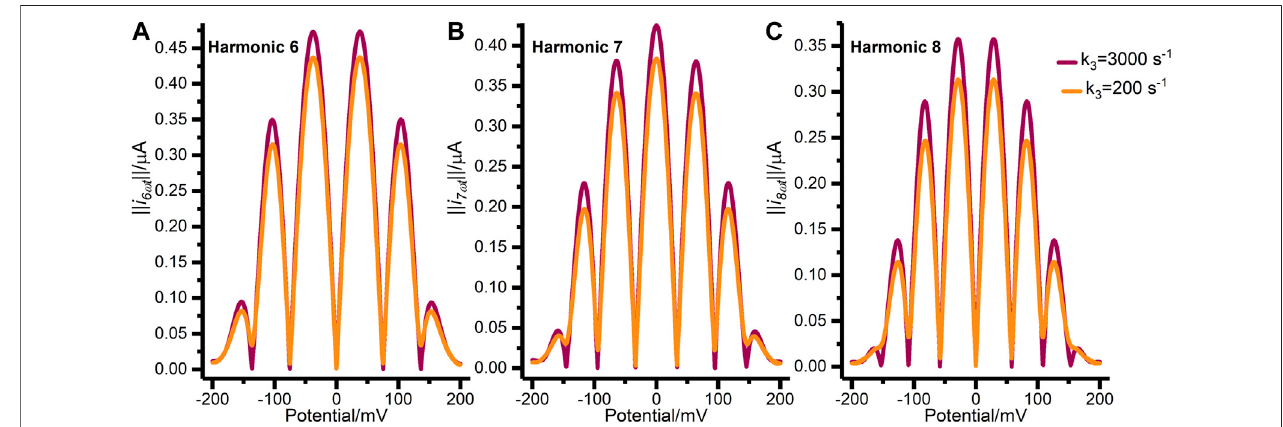
FIGURE 4 | Synthetic FTACV data showing (A) harmonic 6, (B) harmonic 7, and (C) harmonic 8 generated by the concerted two-electron transfer model with k 3 (cid:2) 3 , 000 s − 1 (purple) and k 3 (cid:2) 200 s − 1 (orange). The other parameters used to generate these harmonics were: E start (cid:2) 200 mV, E reverse (cid:2) − 200 mV, f (cid:2) 9 . 0 Hz, Δ E (cid:2) 150 mV, η (cid:2) 0 . 0 rad s − 1 , ζ (cid:2) 1 . 0, Γ (cid:2) 3 . 5 pmol, S (cid:2) 0 . 03 cm 2 , v (cid:2) − 22 . 4 mVs − 1 , T (cid:2) 298 k, α (cid:2) 0 . 5, and uncompensated resistance and capacitance were set 0 3 to